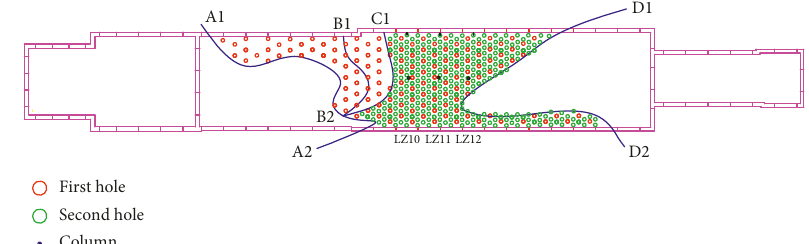
Figure 8: Drilling design of grouting reinforcement.